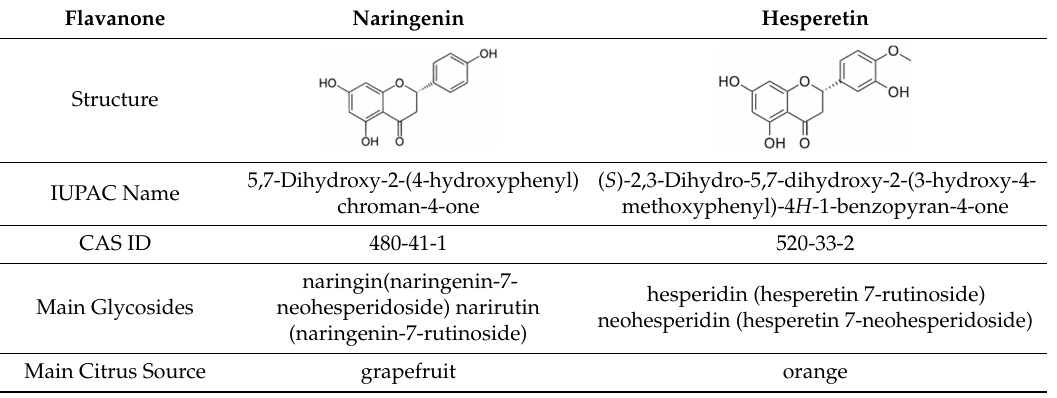
Table 1. Biochemical details of flavonoids incorporated into nanoemulsions (chemical structure, International Union of Pure and Applied Chemistry (IUPAC) name, Chemical Abstracts Service (CAS) identifier (ID), main glycosides and main citrus source).